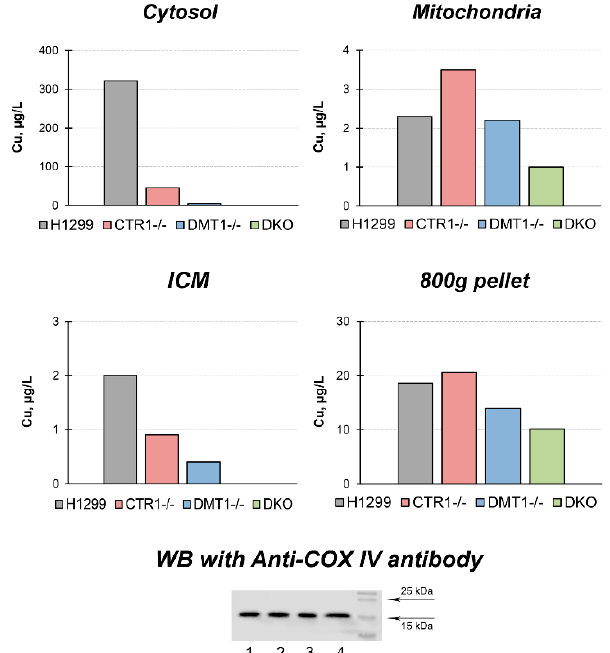
Figure 2. Copper distribution in CTR1 KO, DMT1 KO, and DKO cells. Y-axis: copper concentration (µg/L) in subcellular fractions. Down below: WB with antibodies to Cox4. Lines: 1, H1299 2, CTR1 KO; 3, DMT1 KO; 4, DKO. Each sample contained 30 µg protein.